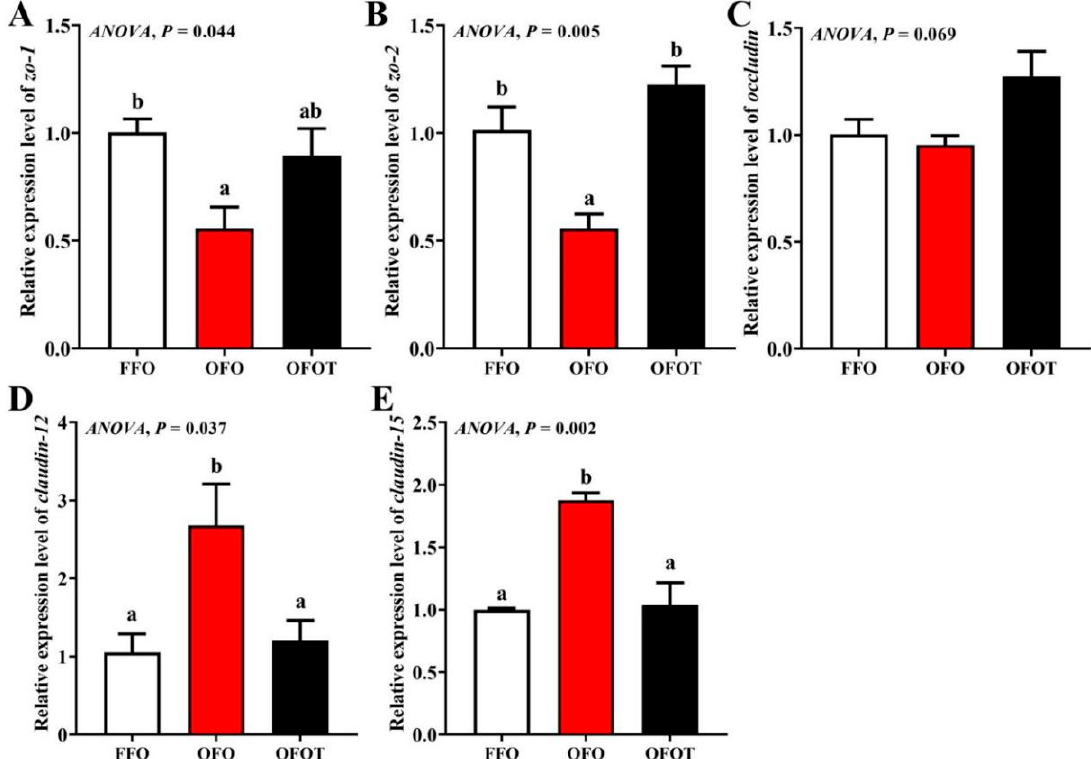
Figure 6. Effects of dietary taurine on intestinal physical-barrier-related genes expression of channel catfish ( Ictalurus punc-